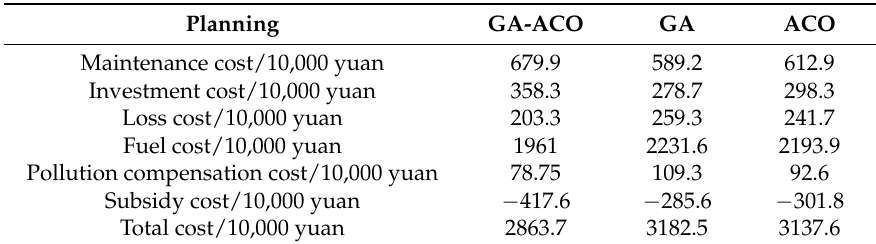
Table 5. Average cost of the three algorithms.